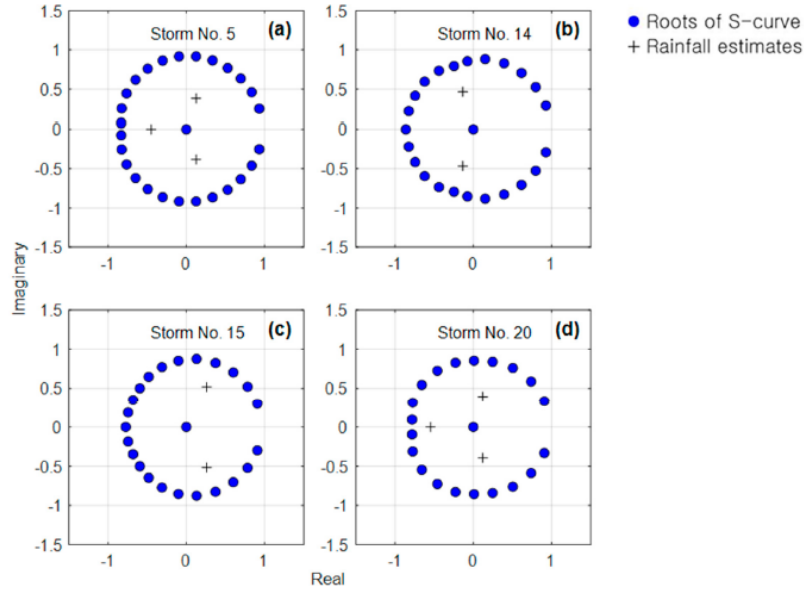
Figure 1. Argand diagrams obtained by the proposed method for selected storms of Nenagh basin: ( a ) for Storm No. 5; ( b ) for Storm No. 14; ( c ) for Storm No. 15; ( d ) for Storm No. 20. The root separation procedure by the SRS method developed by modifying the exist- ing RS method [6] is as follows: (1) select the S-curve roots based on the circle pattern; (2) construct the S-curve using the so-separated roots; and (3) combine the remaining roots to form an estimate of effective rainfall. The complex roots for the direct runoff polynomial for each event plotted in Figure 1 are relevant to the S-curve 𝑆(cid:4632)(𝑧 (cid:2879)(cid:2869) ) and rainfall 𝑋(𝑧 (cid:2879)(cid:2869) ) . In Figure 1, the roots of 𝑆(cid:4632)(𝑧 (cid:2879)(cid:2869) ) represented by dots are spread at a practically equal angle from each other and describe almost perfect circles with a slightly increasing radius from left to right. Approximating the polynomial for 𝑆(𝑧 (cid:2879)(cid:2869) ) is achieved by combining the roots on these circles. To check the validity of the approximation, 𝑆(cid:4632)(𝑧 (cid:2879)(cid:2869) ) is illustrated in Figure 2.